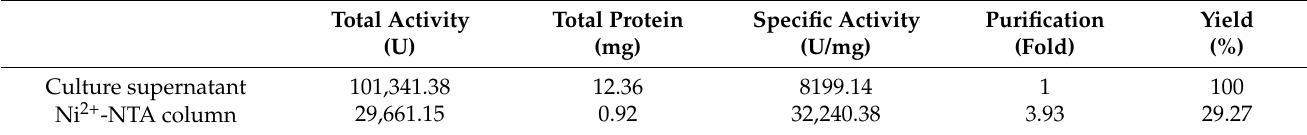
Table 1. Purification of β -1,3-glucanase from Y. lipolytica transformant (pYLSC1- 13g ).